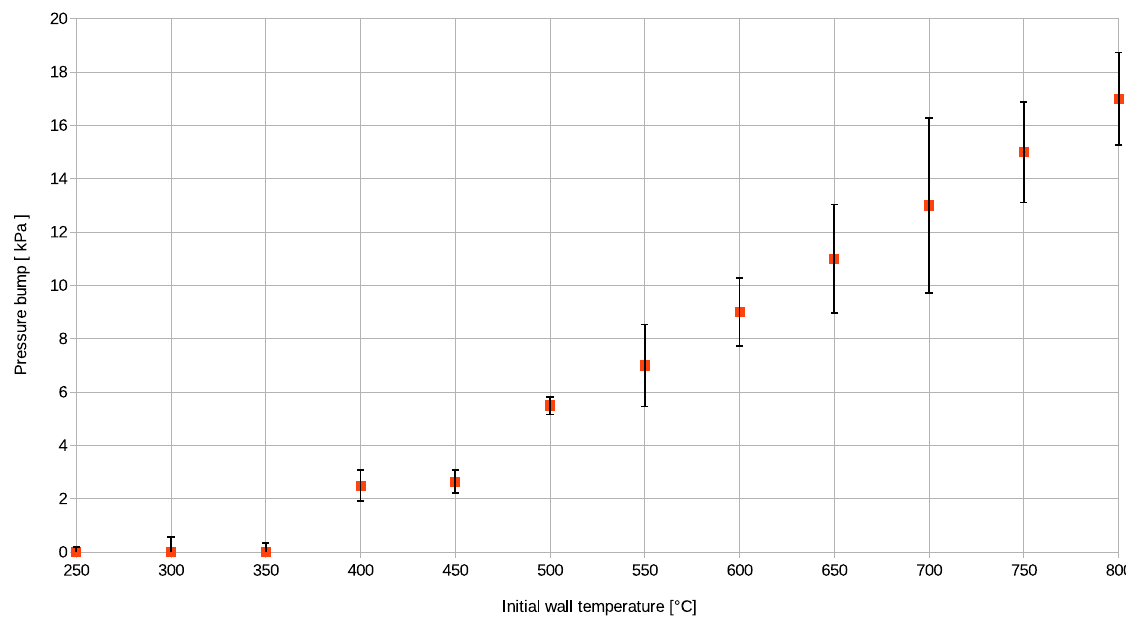
Figure 4. Pressure bump on initial wall temperature.